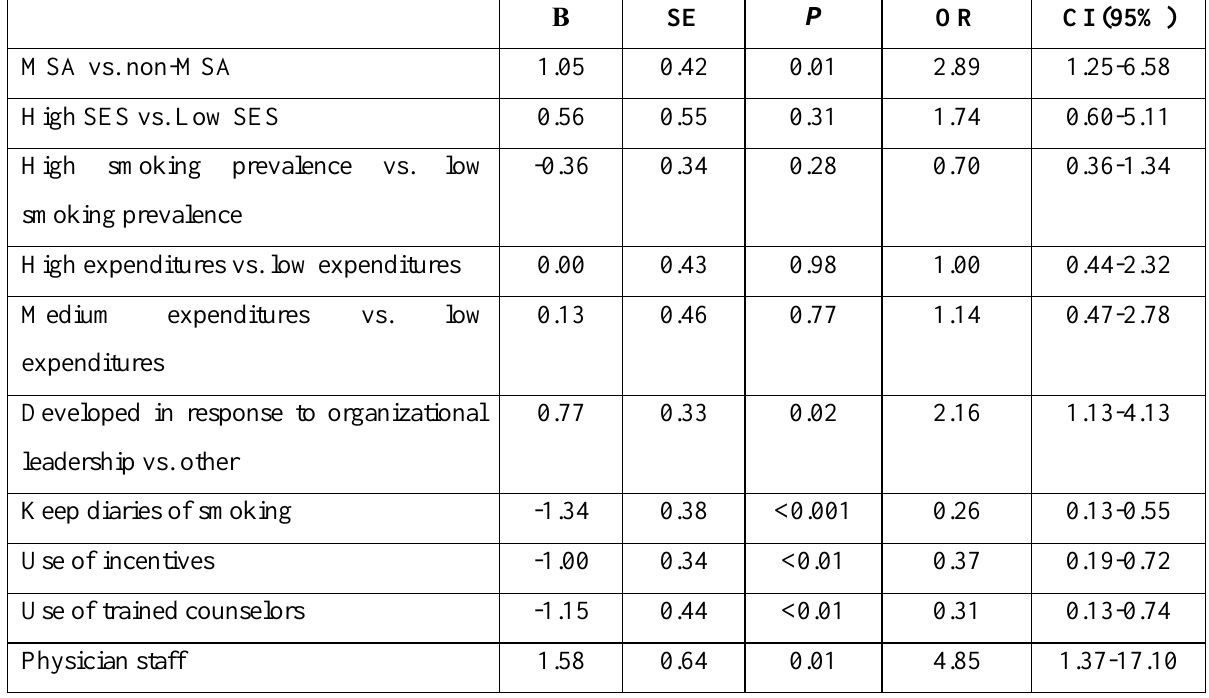
Table 3. Multivariate model for internally-developed and prepackaged